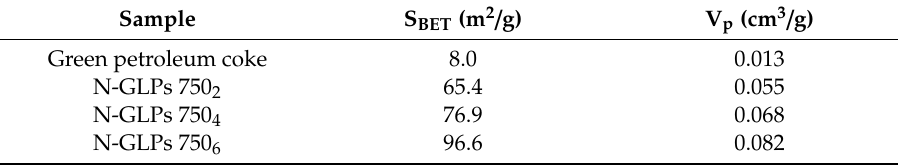
Table 2. Surface area and porous volume of the green petroleum coke and N-doped samples.